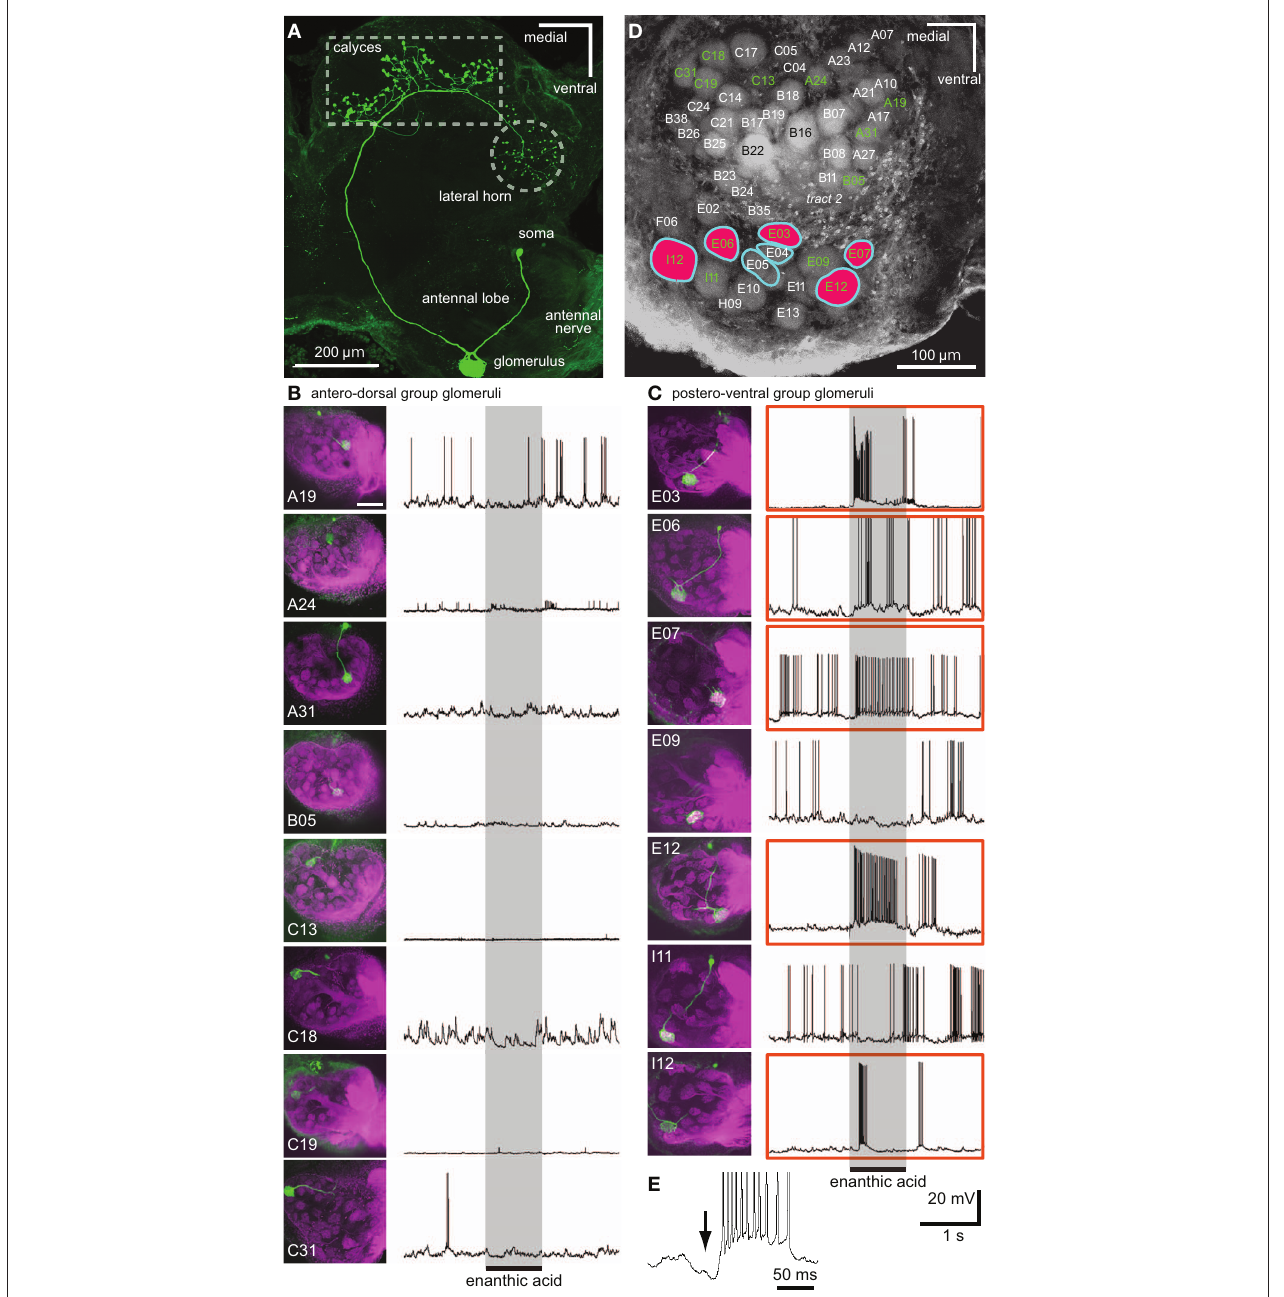
arborizations in E03, 06, 07, 12, and I12 glomeruli (enclosed by orange boxes), exhibited strong excitatory responses to enanthic acid stimulation (shaded areas). Scale bar = 100 µ m in B and C (see upper left image). (D) Summary of the spatial pattern of enanthic-acid responsive glomeruli. The names of 15 glomeruli innervated by intracellularly recorded projection neurons are labeled in green. Five enanthic acid-responsive projection neurons arborize in the glomeruli colored red. In VSD imaging, enanthic acid-induced synchronized potentials in the seven glomeruli surrounded by light blue lines (see Figure 5 ). (E) Enanthic acid-induced hyperpolarizing membrane potential (arrow) before the depolarizing phase recorded from a uniglomerular projection neuron with dendrites in I12